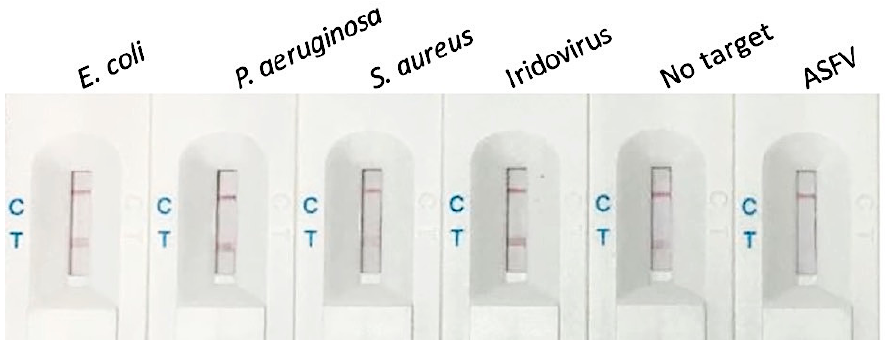
Figure 5. Selectivity assay using di ff erent strains. Biosensor images with test and control lines responses corresponding to the subjected 10 4 cfu / mL